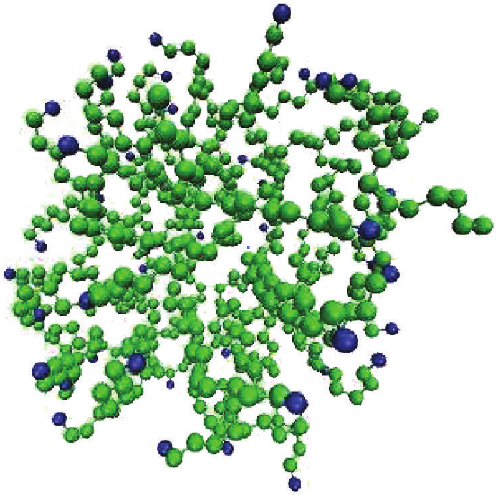
Figure 3: The fractal cluster as an inherent micelle in liquid